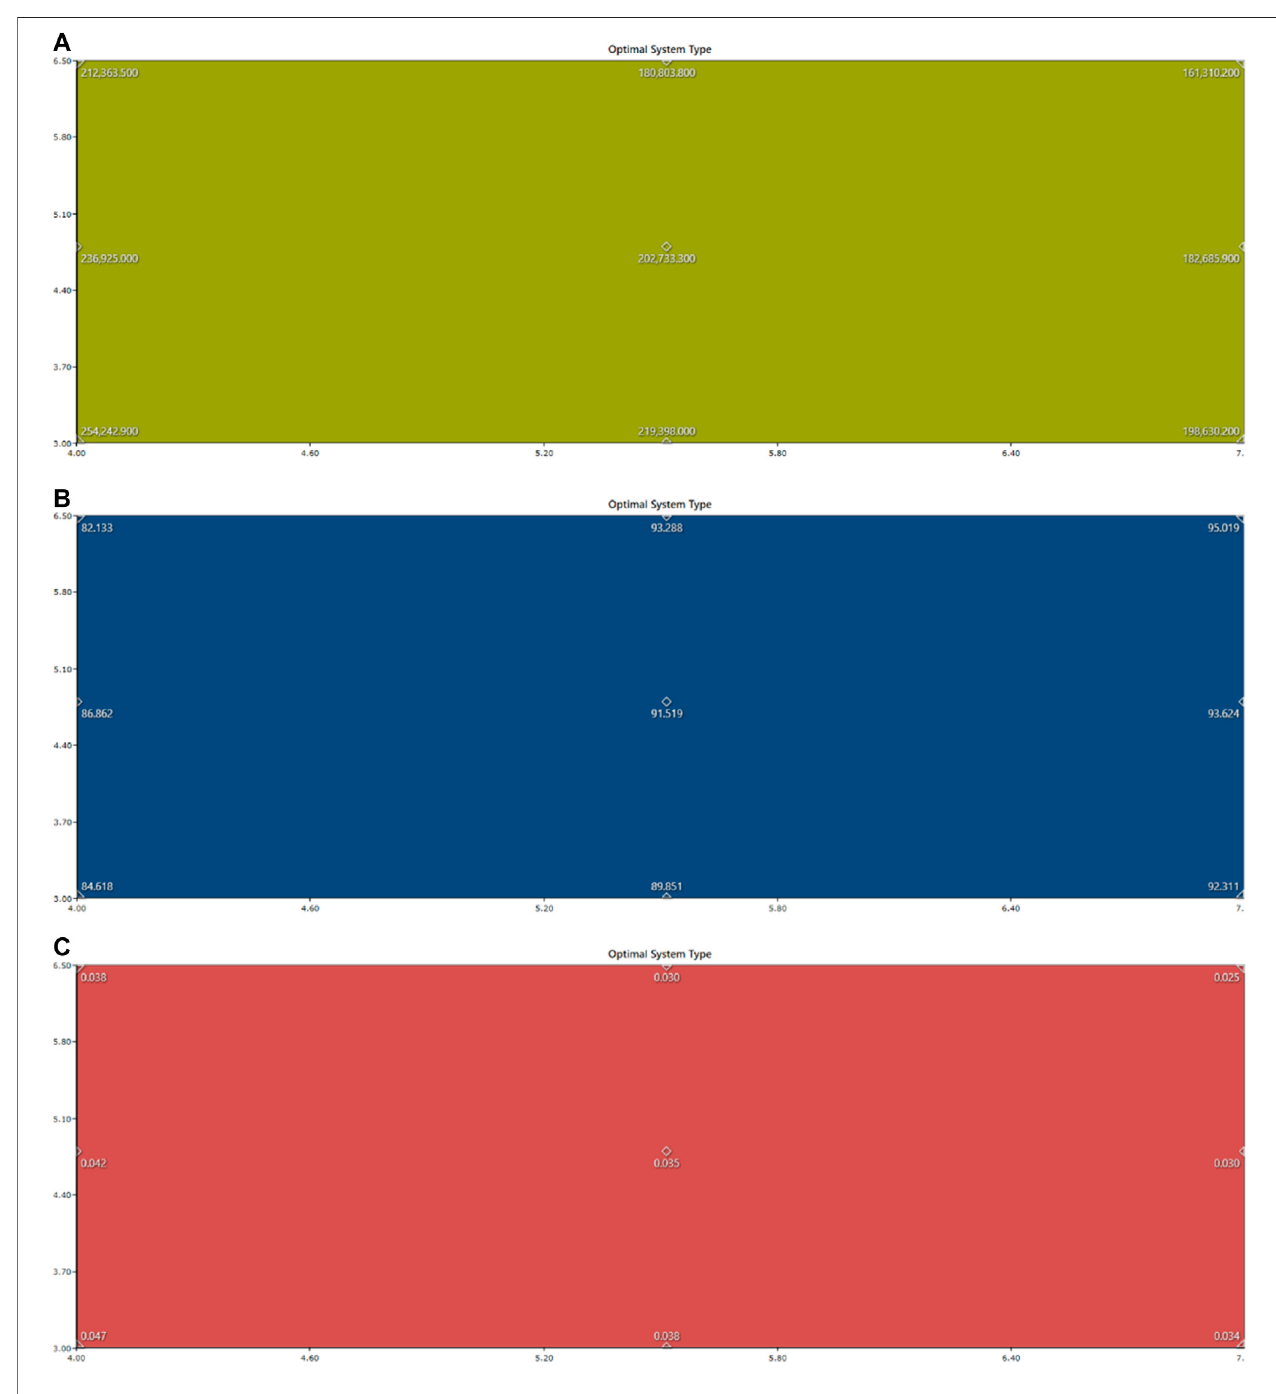
FIGURE 8 | (A) Optimal system type plot for Net Present Cost. (B) Optimal system type plot for RF. (C) Optimal system type plot for